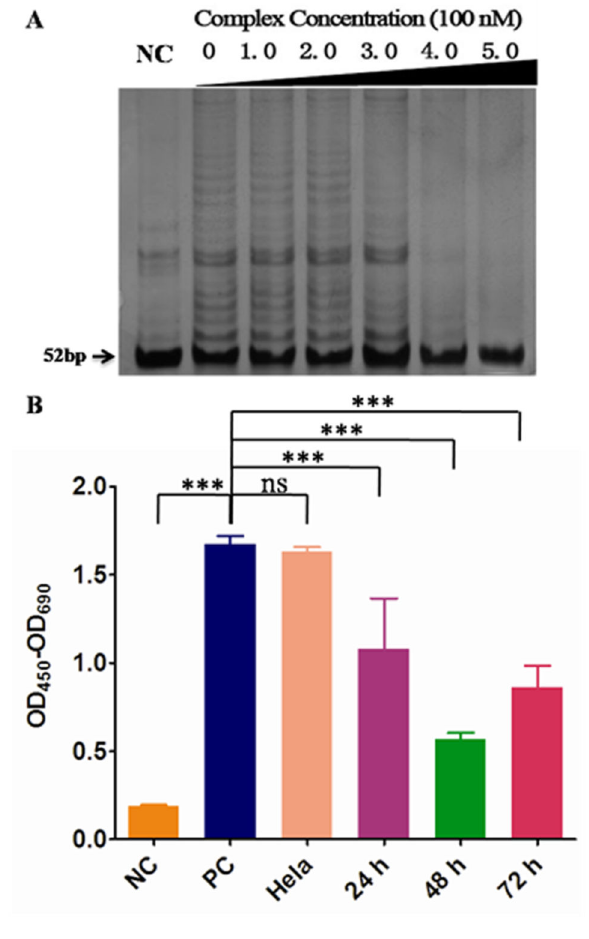
Figure 8. Telomerase inhibition by [(dmb) Ru(obip)Ru(dmb) ] 4+ . TRAP Assay with Hela cells at 2 2 gradient concentrations of [(dmb) Ru(obip)Ru(dmb) ] 4+ for 24 h 2 2 shown in (A), quantitative analysis of the telomerase inhibition